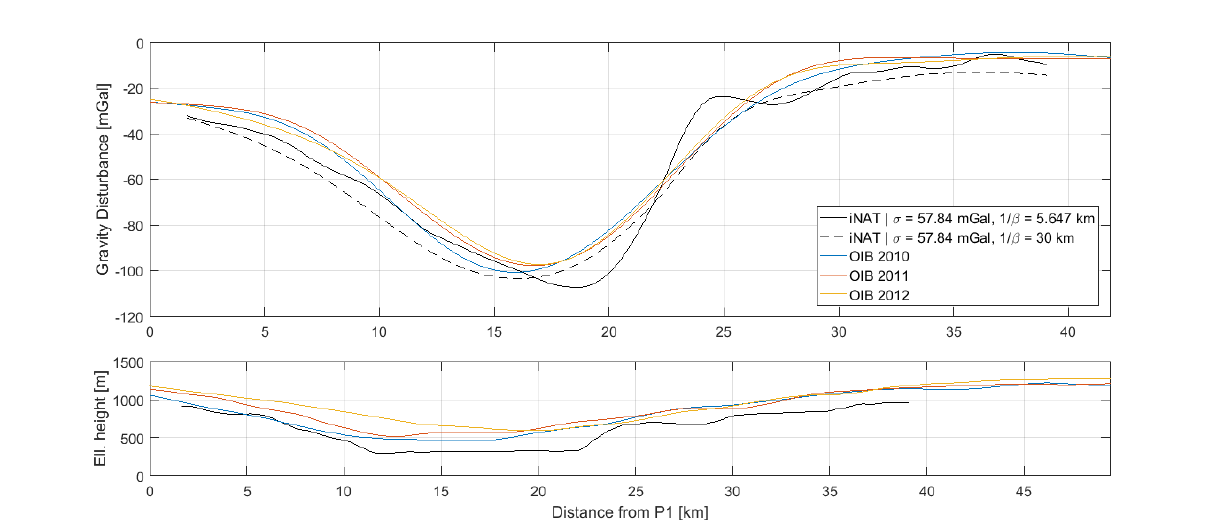
Figure 6. Gravity disturbance estimates for the profile between P1 and P2 for two different Gauss–Markov correlation lengths: ( top ) gravity disturbance profile; ( bottom ) height